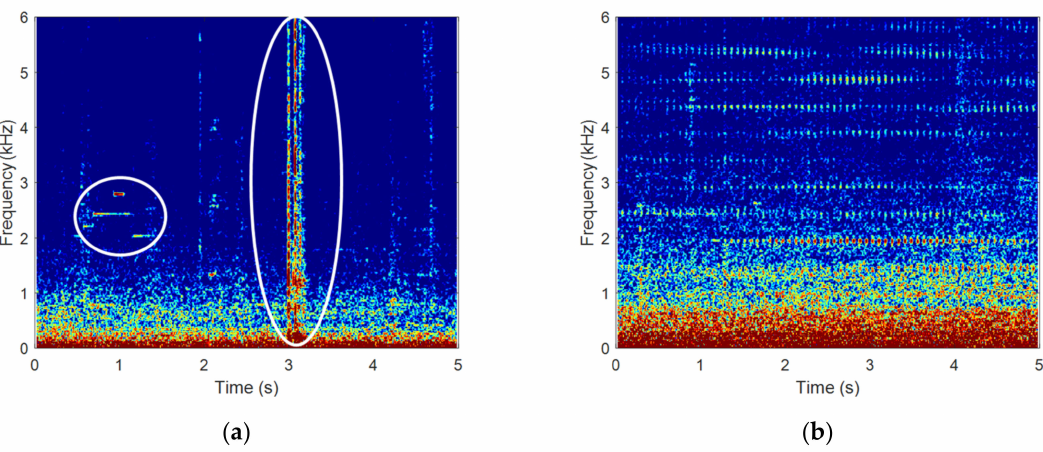
Figure 12. Spectrogram of acoustic signals measured at near blower of air-conditioner (AC): ( a ) case of normal AC with impulsive noises and beep sounds; ( b ) case of faulty AC with abnormal noises.